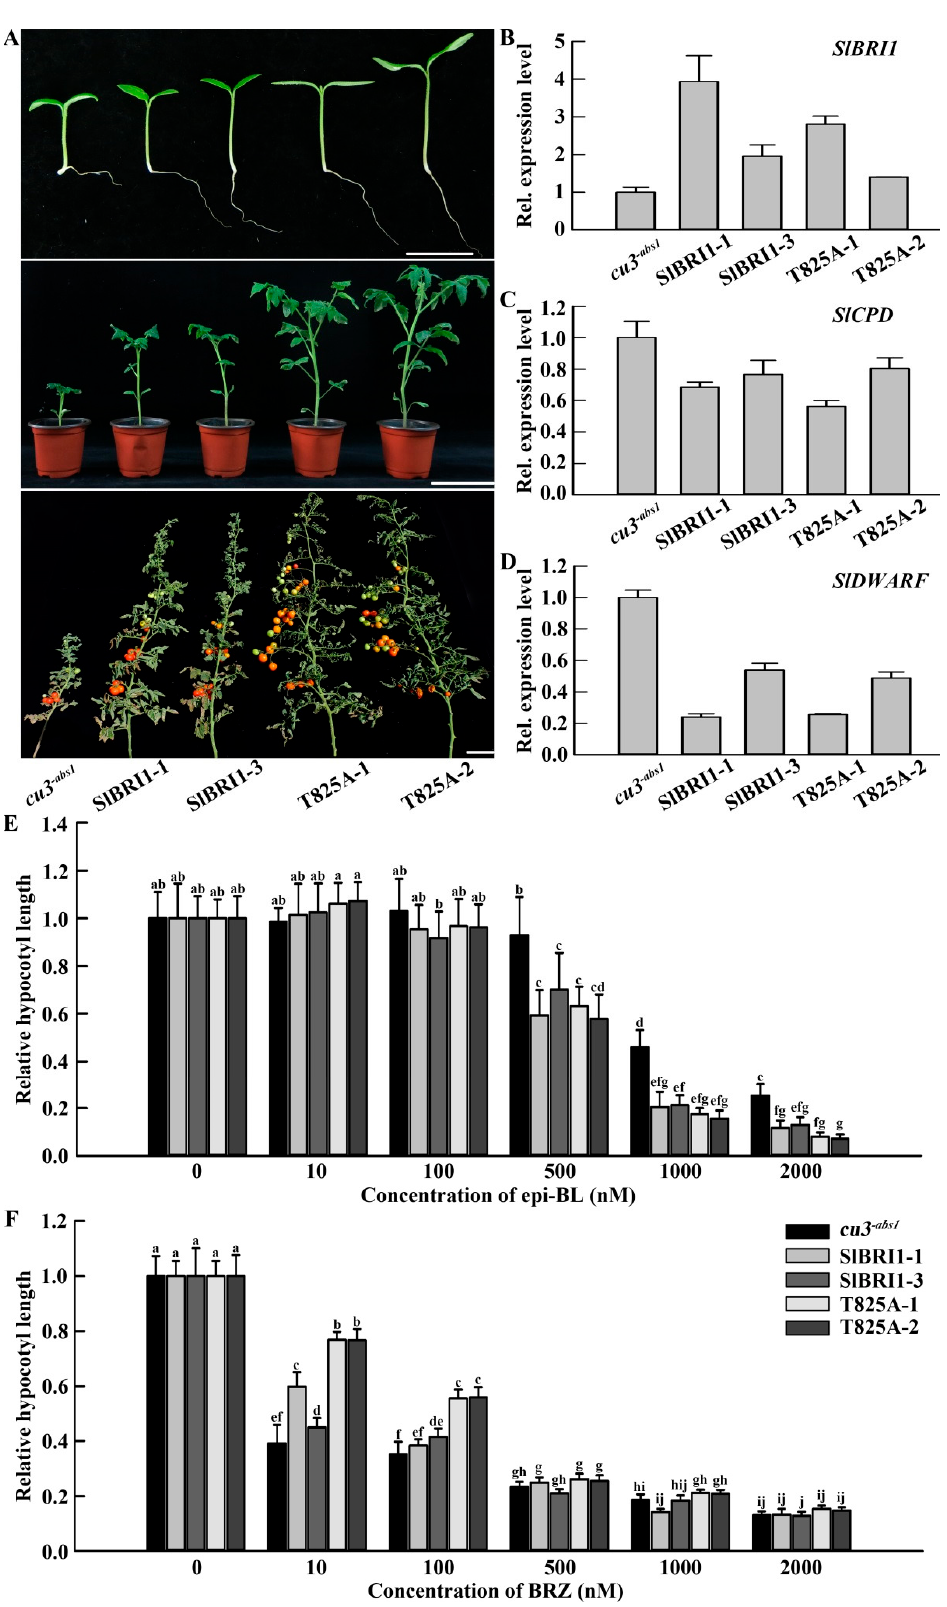
Figure 2. SlBRI1 T825A affects BR signaling. ( A ) The plant phenotypes. From top to bottom: phenotypes of plants at the germination stage (7 days after sowing), seedling stage (42 days after sowing), and maturation stage (maturation period of the fourth fruit cluster of the P SlBRI1 ::T825A lines). Scale bars represent 2 cm, 10 cm, and 14 cm, respectively. ( B )